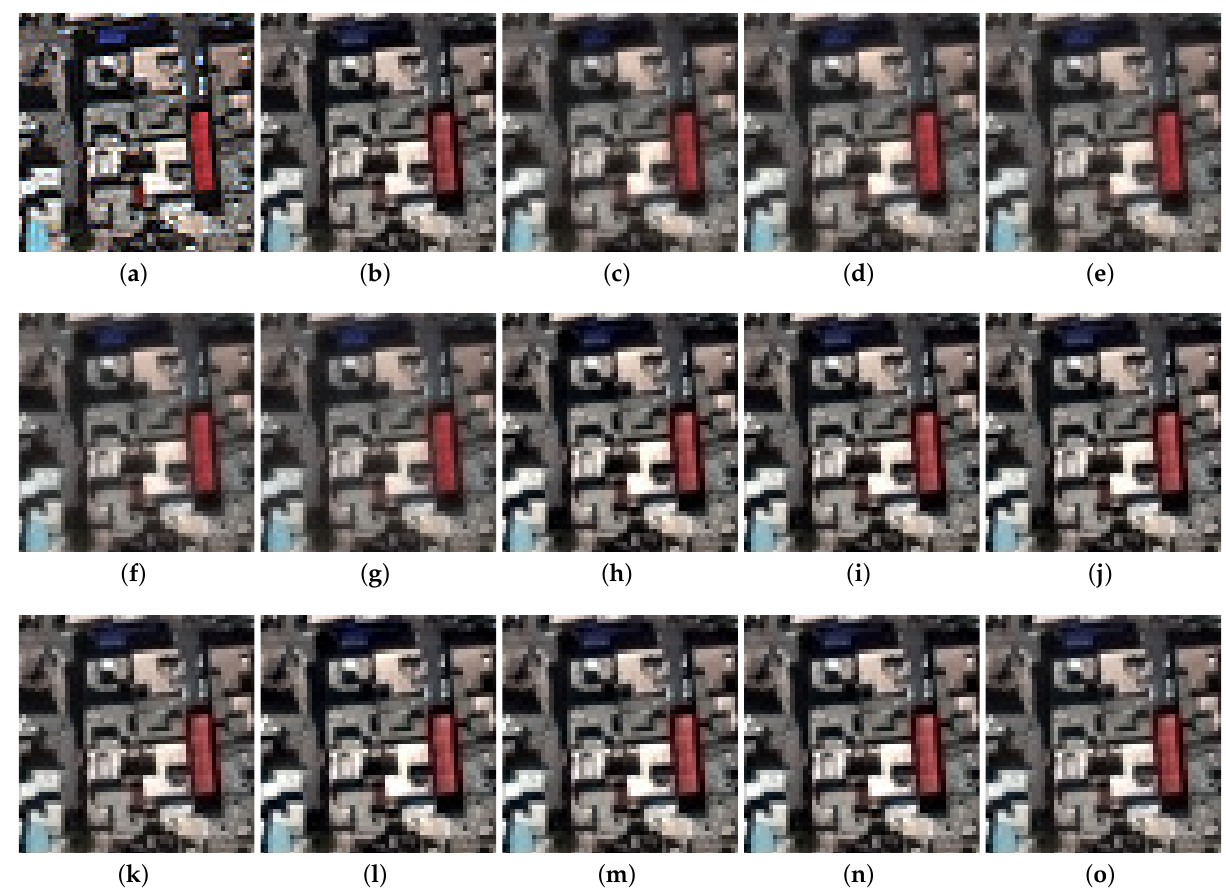
Figure 5. Close-ups of the fused results using the reduced resolution Tripoli dataset: ( a ) GT; ( b ) GSA; ( c ) MF-HG; ( d ) MBFE- BDSD-HPM; ( e ) MBFE-GSA-HPM; ( f ) FE-HPM; ( g ) GLP-HPM; ( h ) MBFE-BDSD-CBD; ( i ) MBFE-GSA-CBD; ( j ) FE-CBD; ( k ) GLP-CBD; ( l ) MBFE-BDSD-MLR; ( m ) MBFE-GSA-MLR; ( n ) FE-MLR; ( o )